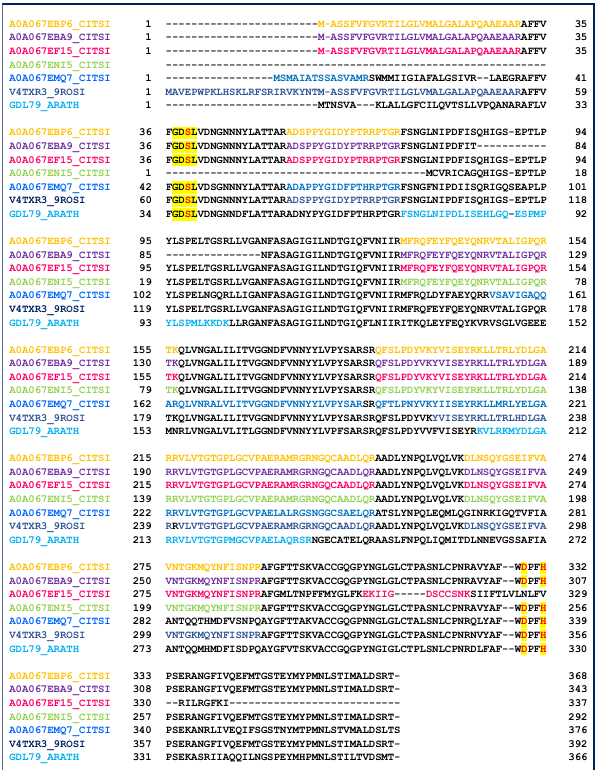
Figure 5. Alignment of the six identified GDSL variants with the sequence of A. Thaliana (GDL79_ARATH). MS/MS validated sequences are colored, while the yellow highlight the GDSL motif and the active sites (red amino acids).